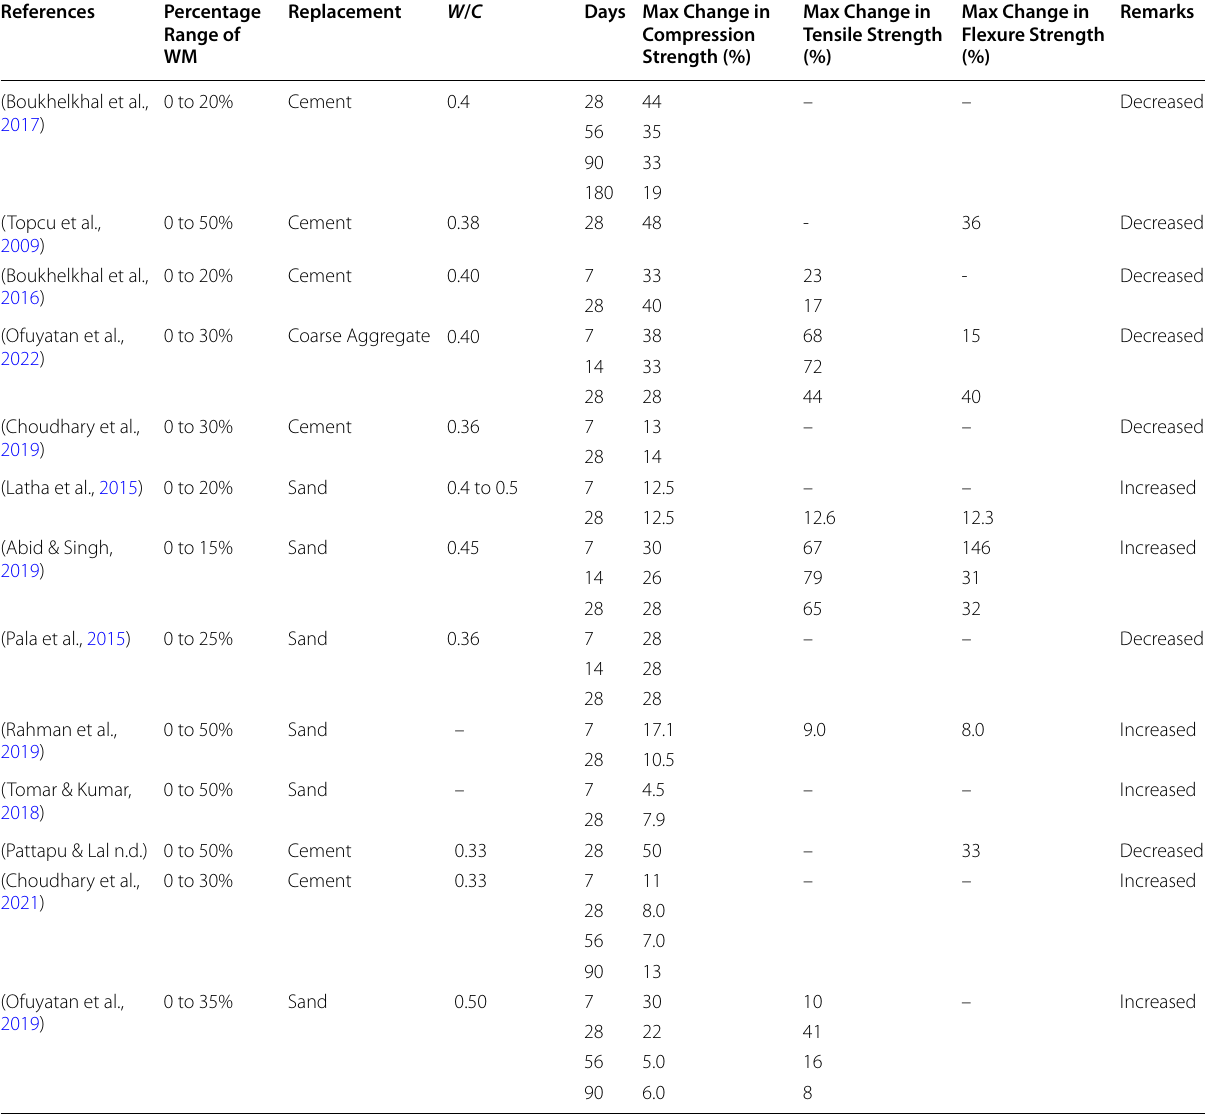
Table 2 Strength Properties of Concrete with